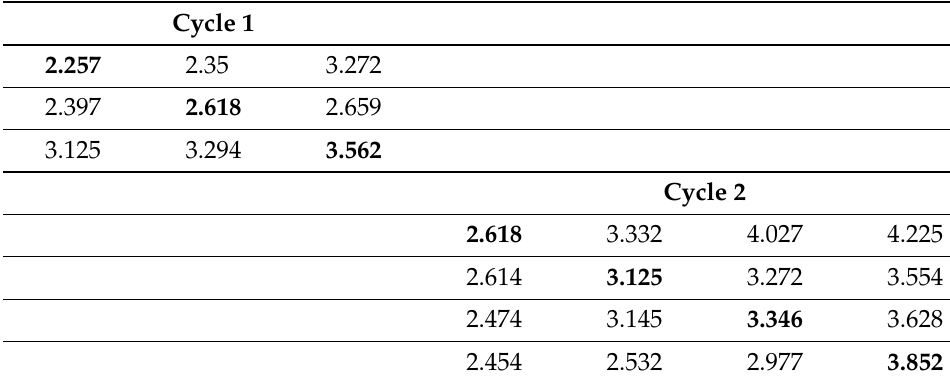
Table 16. RSS scheme from the GB( θ , λ ) distribution when c = 2 and n = 7.